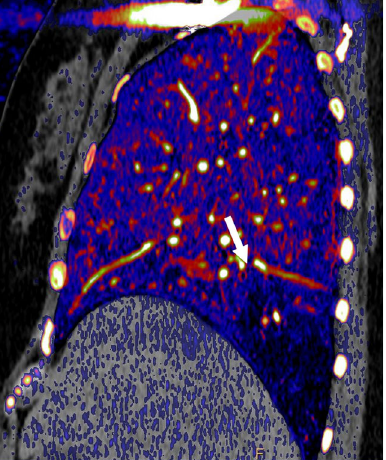
Fig. 9 Perfusion imaging with iodine maps. Sagittal iodine overlay image in a patient with acute chest pain shows a wedge-shaped perfusion defect in the right lower lobe ( arrow ), which is consistent with an acute pulmonary embolism. CTA in this patient (not shown here) did not show the clot clearly